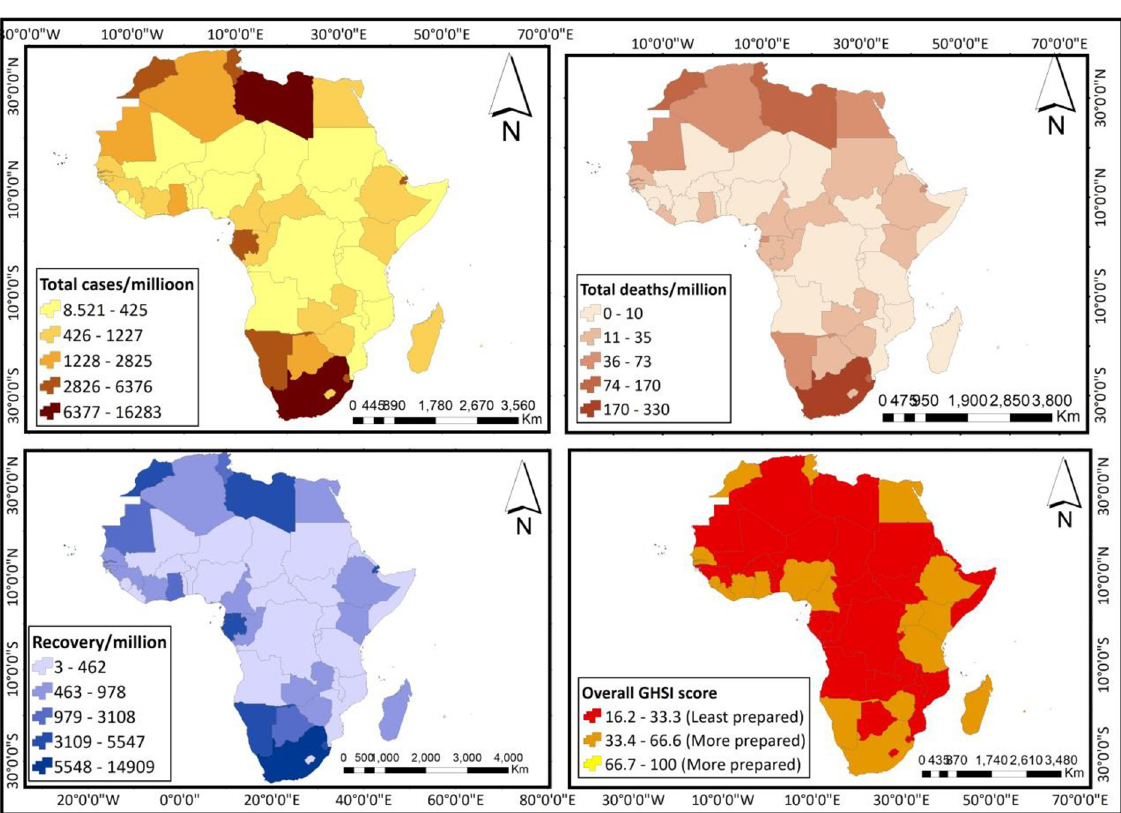
Fig 2. Spatial representation of data on outcome and key predictor variables (reprinted from https://tapiquen-sig.jimdofree.com/ descargas-gratuitas/mundo/, under a CC BY license, with permission from Carlos Efrain Porto Tapiquen, 2021).